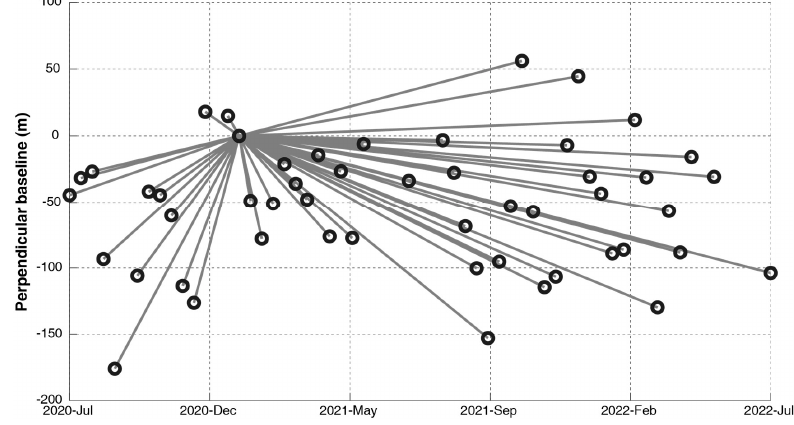
Figure 4. Persistent scatterer InSAR network used in this study.